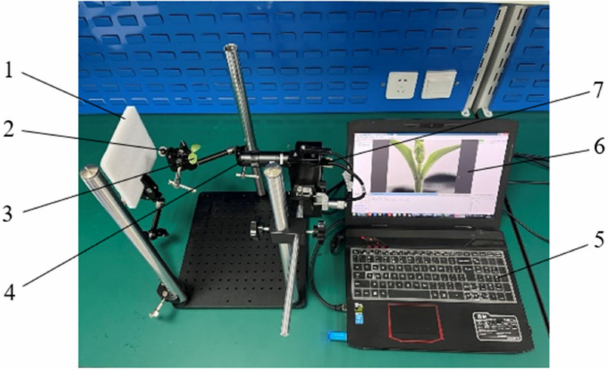
Figure 4. Structure of the visual system: (1) white board, (2) seedling clamping module, (3) seedling, (4) CCD camera, (5) PC, (6) software interface, and (7)